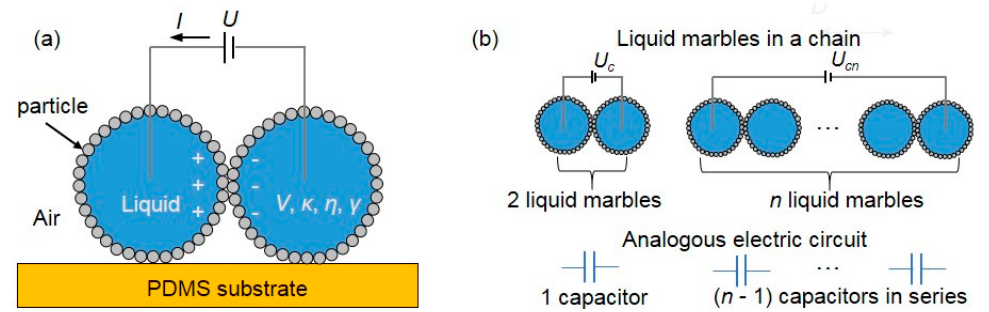
Figure 17. ( a ) Schematic of the coalescence of two charging LMs resting on a polydimethylsiloxane (PDMS) substrate. V , κ , η , γ are the volume, electrical conductivity, viscosity and surface tension of the liquid core respectively. The voltage U is applied through the electrodes inserted into the liquid marbles. The current I is monitored through an ammeter during the coalescence process; ( b ) sketch of a chain of liquid marbles charged by a voltage and its analogous electric circuit.